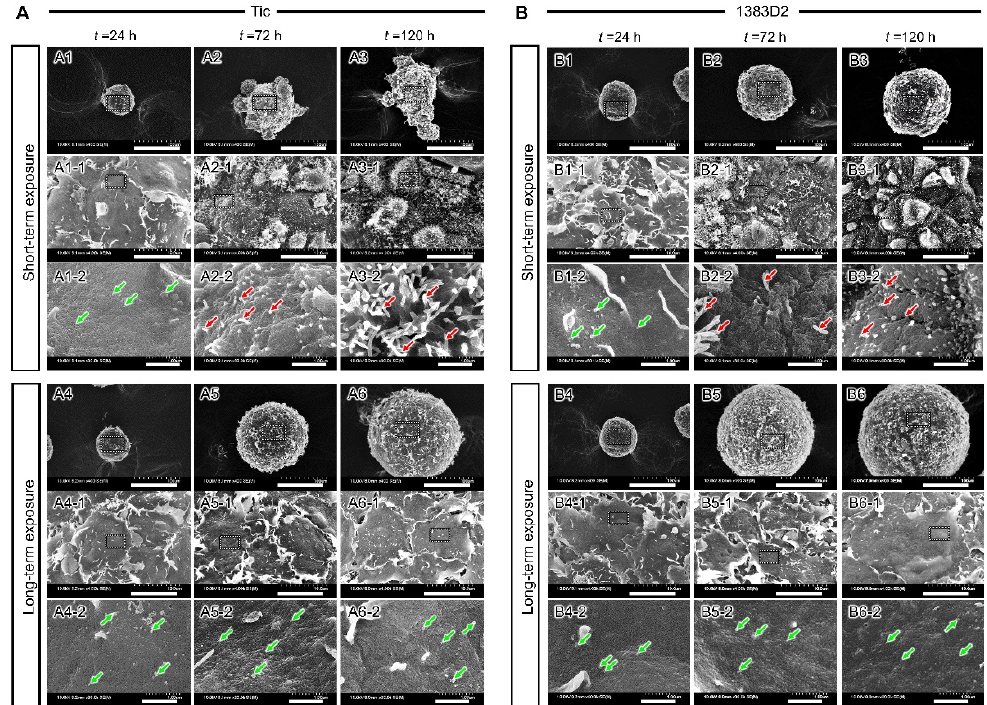
Figure 5. Scanning electron microscopic images showing structural changes in surface of cell aggre- gates under short- and long-term exposure conditions at 24, 72, and 120 h (( A ), Tic; ( B ), 1383D2). Panels ( A1-1 – B6-1 , A1-2 – B6-2 ) show magnified views of the boxed area. Green arrows and red arrows indicate particle structures and fibril structures, respectively. Scale bars: 100 µ m ( A1 – B6 ), 10 µ m